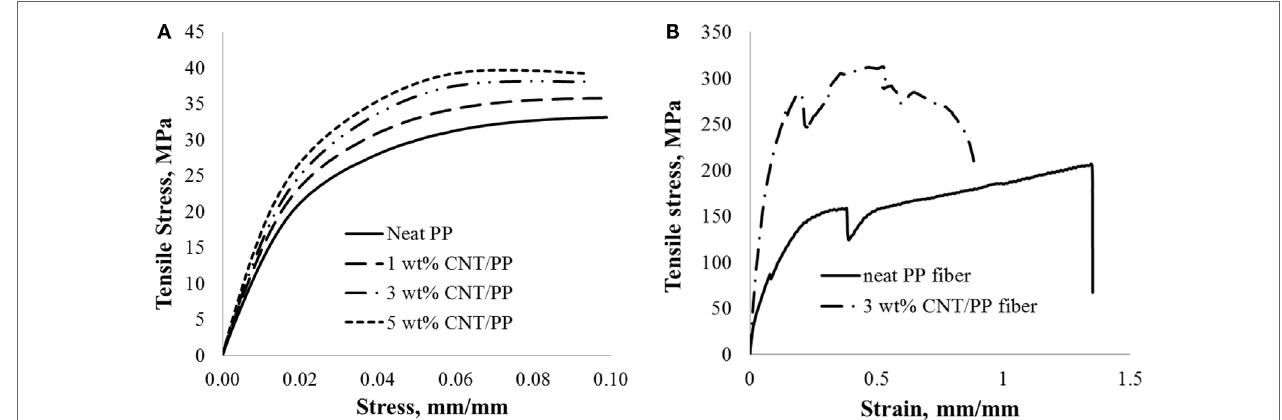
FigUre 4 | Tensile stress–strain plots of cnT/PP composites: (a) bulk and (B)